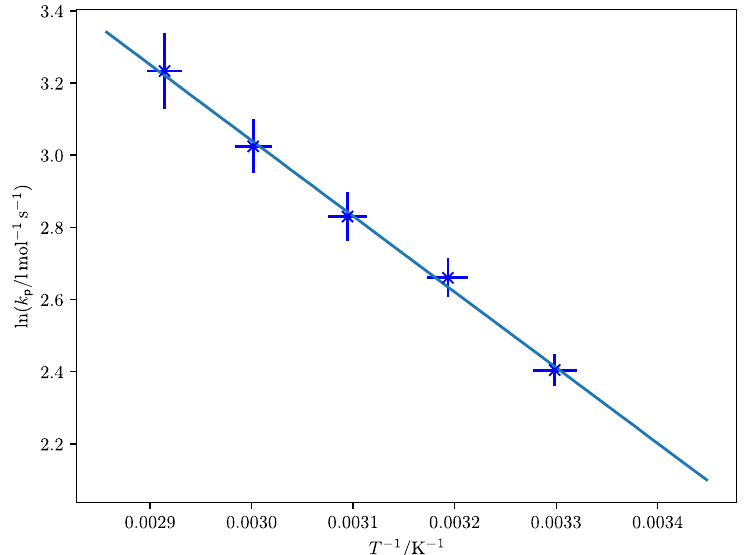
Figure 4. Arrhenius fit for k p of DEI. The indicated uncertainties in ln( k p ) result from the standard deviation of the measurements for the respective temperature, while for the uncertainty in T − 1 an uncertainty of ∆ T = 2 K was assumed. The obtained Arrhenius parameters are shown in Table 3. Table 3. Experimental Arrhenius parameters for chain ‐ length ‐ averaged k p of DEI, obtained via PLP ‐ SEC.